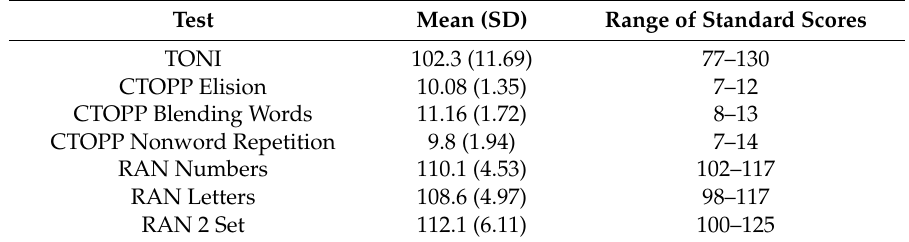
Table 2. Descriptive statistics for the reading battery and non-verbal IQ test. Means, standard deviations (SD) in parenthesis, and ranges of the standard scores for each test are